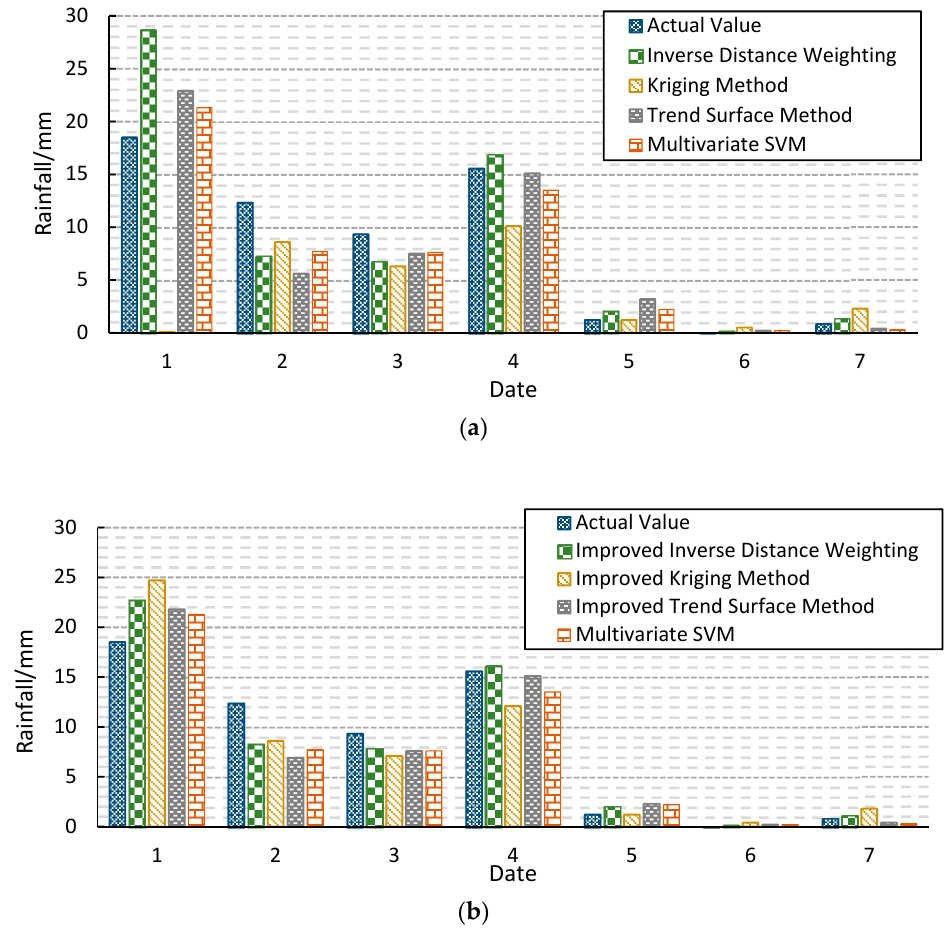
Figure 17. ( a ) The comparison of the interpolation effects of different methods. ( b ) The comparison of Figure 17. (a) The comparison of the interpolation effects of different methods. the interpolation effects of different improved (b) The comparison of the interpolation effects of different improved methods.